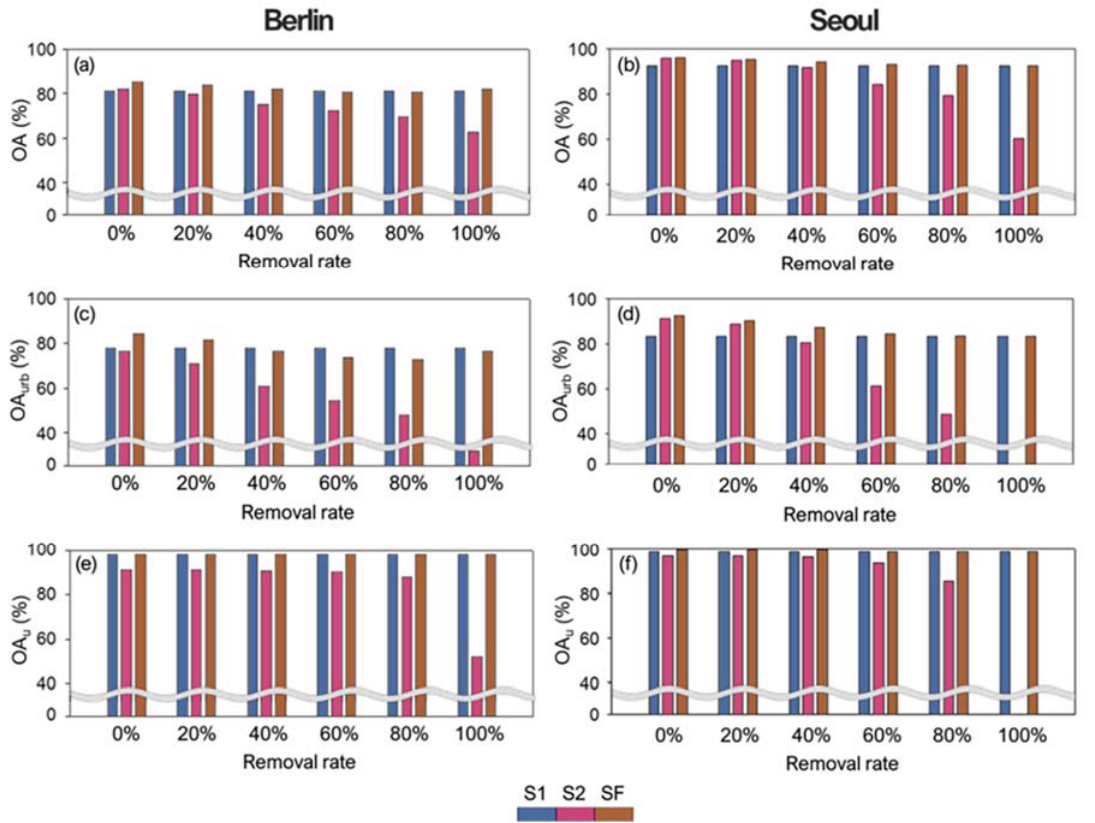
Figure 10. Accuracy assessment results (OA ( a , b ), OA urb ( c , d ) and OA u ( e , f )) of three schemes with removing building components at di ff erent rates (0%, 20%, 40%, 60%, 80%, and 100%) for Berlin ( a , c , e ) and Seoul ( b , d , f